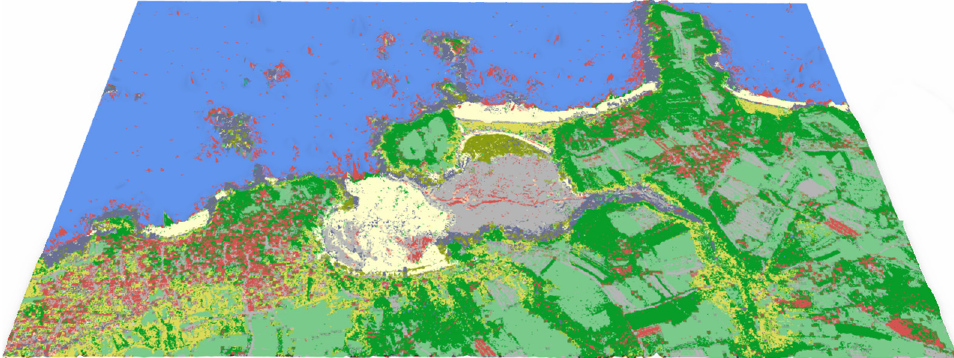
Figure 13. Best map classification draped over the best digital surface model.